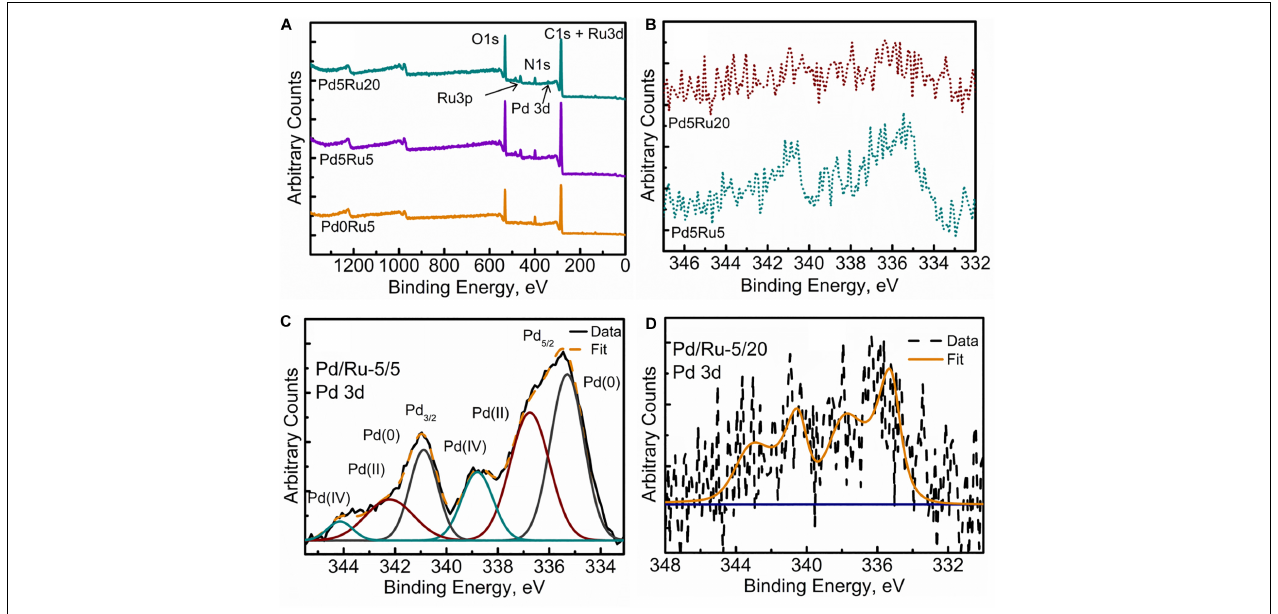
FIGURE 6 | XPS spectra of (A) Wide Energy Survey Spectra (WESS) for all three samples, (B) high resolution Pd 3d spectra, and fitted components for (C) Low Pd and Ru loading sample and (D) low Pd high Ru loading sample.